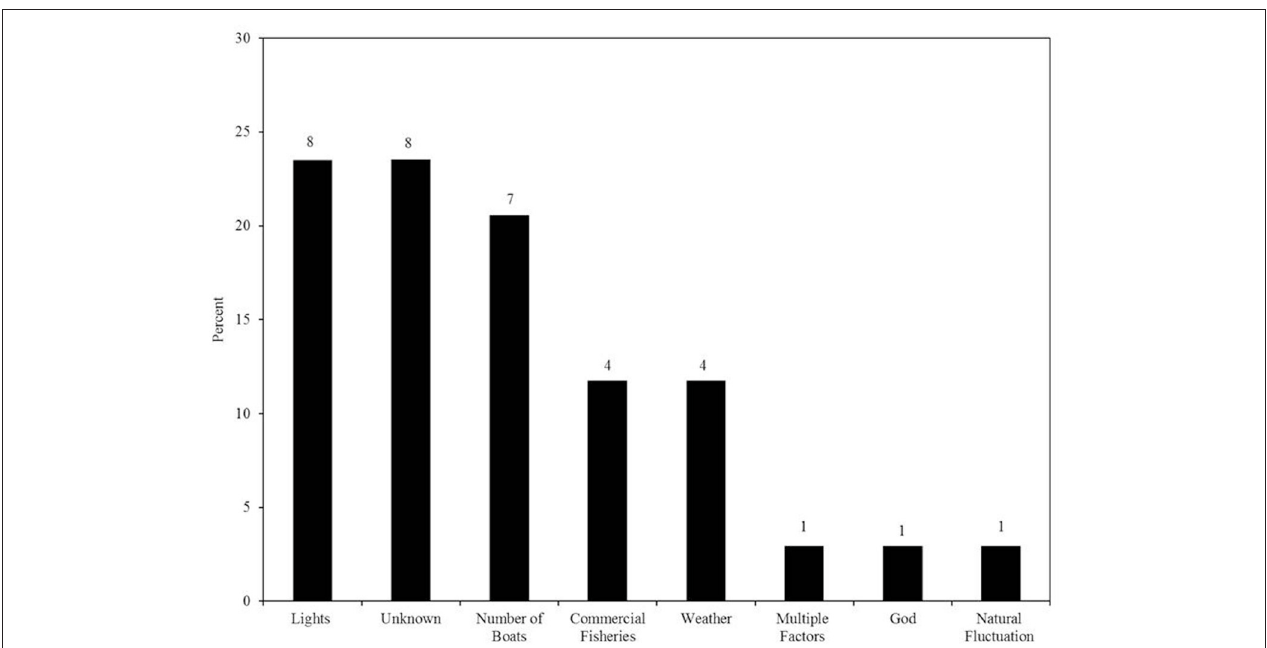
FIGURE 2 | The frequency of responses given by fishers to explain why they have observed a decrease in fish catch over recent years. Data are presented across all sites included in the study.